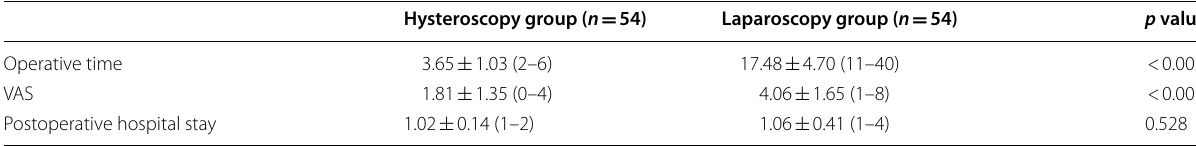
Table 3 The operative time, postoperative VAS score (i.e., postoperative pain), and postoperative hospital stay (in days) in the studied groups